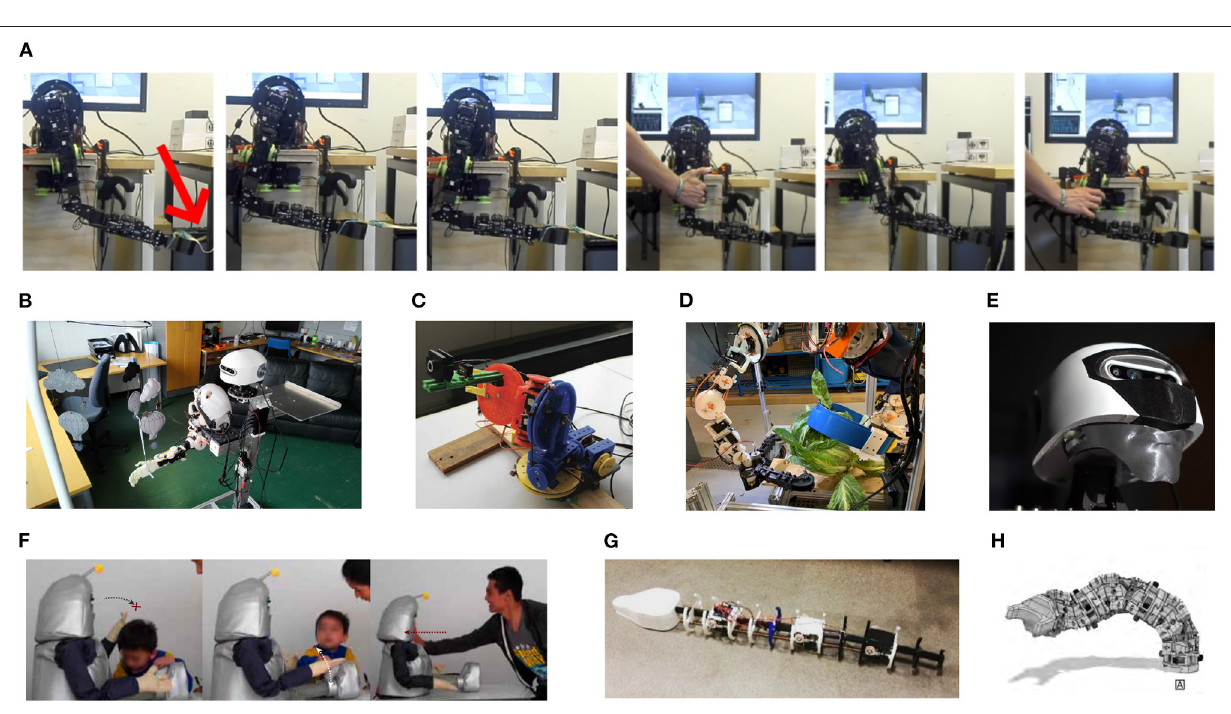
FIGURE 14 | Example applications of the GummiArm, and its related concepts. (A) rhythmic movement generation and online frequency adaptation (Degroote et al., 2020). (B) exploration and exploitation of sensorimotor contingencies (Houbre et al., 2020). (C) visual-servoing on low-accuracy, low-cost arms (Bonsignorio and Zereik, 2020). (D) robust Arms for robotic cauliflower harvesting (Klein et al., 2019). (E) a parametric, modular and open source robot head for the GummiArm (Netzev et al., 2019). (F) soft and robust arms for a huggable social robot (Casas-Bocanegra et al., 2020). (G) a variable stiffness actuated snake (Draper et al., 2017). (H) a modular and stackable actuator with variable stiffness (Wilmot and Howard,